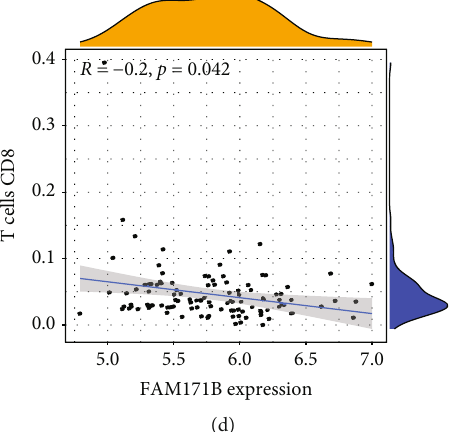
Figure 11: Visualization of the results of immune cell in fi ltration and FAM171B correlation analysis based on the combined data matrix of GSE113439 and GSE117261. (a) Correlation between FAM171B and in fi ltrating immune cells. The size of the dots represents the strength of the correlation between genes and immune cells: the larger the dots, the stronger the correlation and vice versa. The color of the dots represents the P value: the greener the color, the lower the P value, and the yellower the color, the larger the P value. ( P < 0 : 05 was considered statistically signi fi cant.) The correlation analysis in the expression of FAM171B and mast cells resting (b), monocytes(c), and CD8 T cells